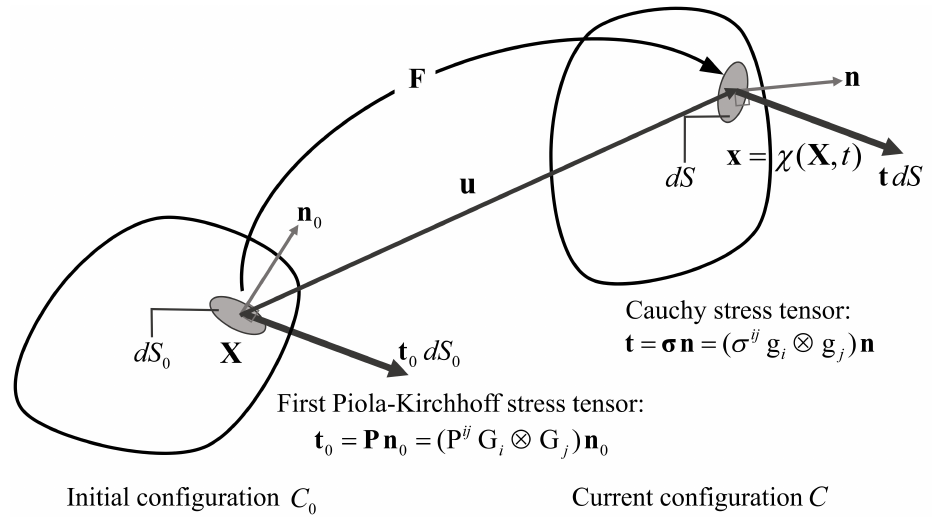
Figure 4. Definition of the First Piola–Kirchhoff stress tensor and Cauchy stress tensor and transfor- mation of a material